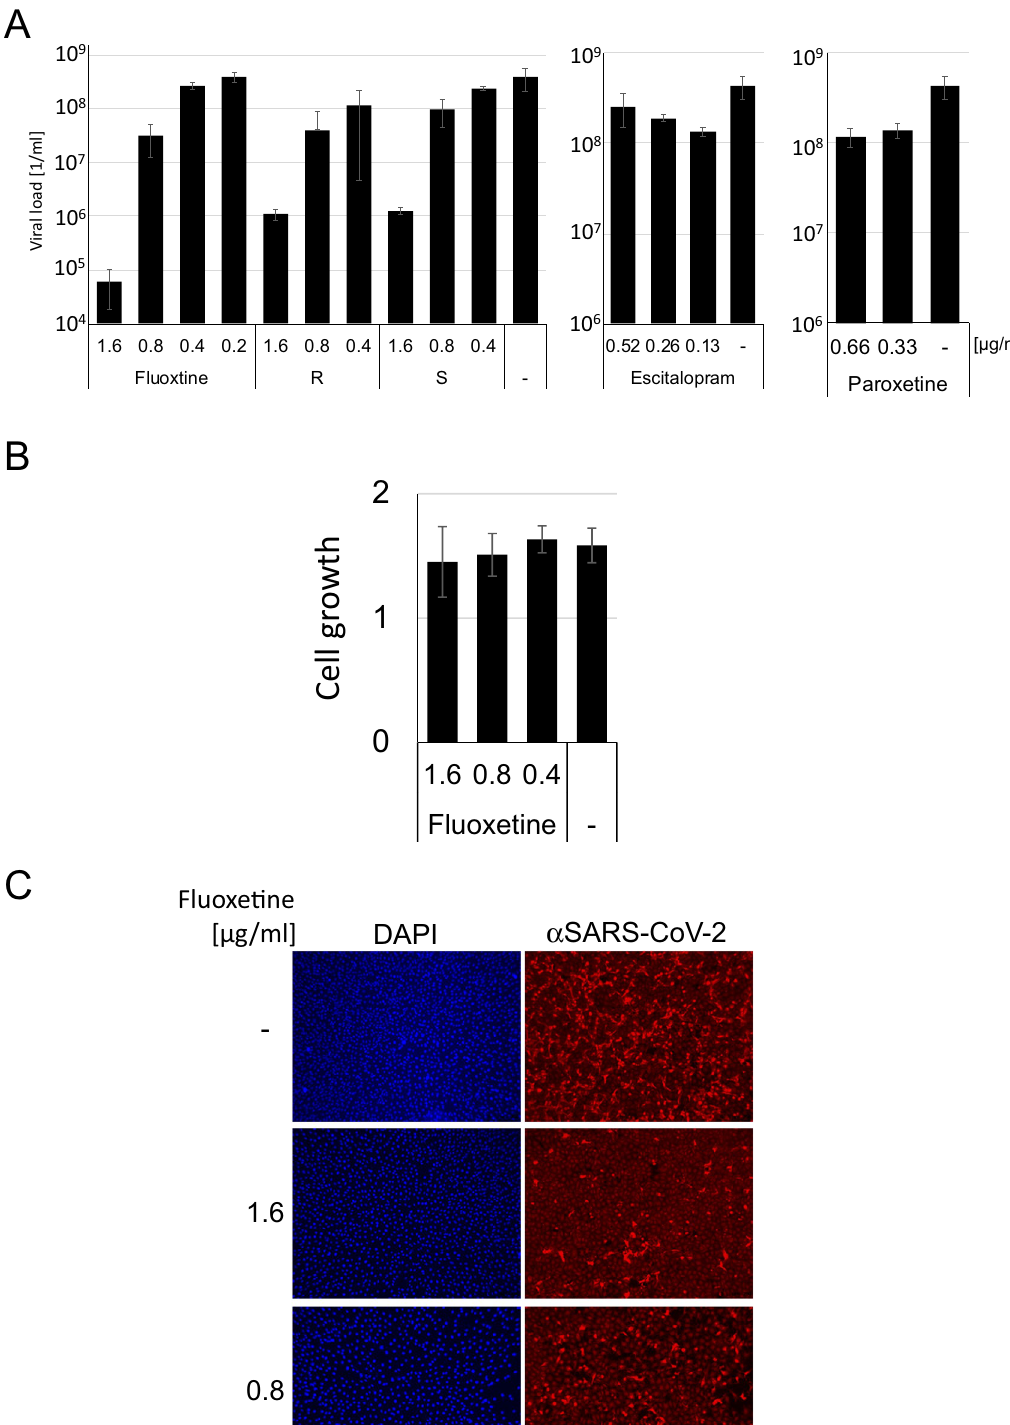
Figure 1. Fluoxetine inhibits SARS-CoV-2 replication. ( A ) Vero cells were incubated with the compounds and subsequently infected with SARS-CoV-2 ( S S-stereoisomer, R R-stereoisomer). Cellular supernatants were collected 3 days after infection, and viral titers were determined with RTqPCR. ( B ) Fluoxetine is not toxic in Vero cells at concentrations used for the treatment of depression (0.8 µg/ml (= 2.58 µM)). Relative growth of Vero cells was determined. ( C ) Vero cells were infected with SARS-CoV-2 for 72 h, and viral proteins were detected with a SARS-CoV-2 specific antiserum (1:100) and a TexasRed-labeled donkey anti-human antibody (1:500, Dianova). The nuclei were stained with